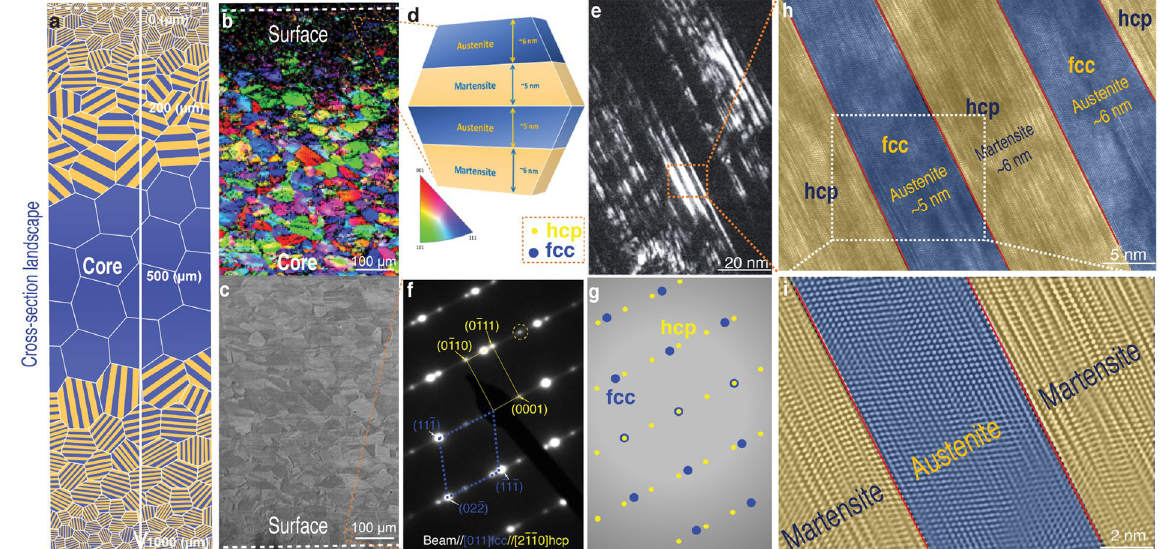
Figure 3. Multi-scale structural characterization of the hierarchical steel. ( a ) Schematic of the gradient in grain size distribution of our hierarchical steel with depth from one topmost surface (outlined by dashed line) to the lower surface of the steel (~1000 µ m in total). ( b ) The EBSD phase map and ( c ) SEM micrograph across the cross-section. ( d ) Nano-sized martensite and austenite phase distribution in one typical grain. Grain sizes are about 15 to 20 nm at the topmost surface, outlined by dashed line in ( b) ,( c ) and ( e ). A typical dark-field TEM image taken at ~100 nm deep underneath the surface of our steel where bright area/bands are ε -hcp martensite. ( f) The SAED patterns corresponding to ( e) clearly show the combination of diffraction spots from both austenite and ε -hcp martensite. ( g ) Schematic illustration of the SAED patterns of ( e) The relatively weak spots (yellow spots) are from the ε -hcp martensite, with the axis of [2110] hcp, and the relatively strong spots (blue spots) are from the austenite, with the axis of [011] fcc. The austenite has the following orientation relationship with the ε -hcp martensite: [011] fcc and [2110] hcp, and (111)fcc//(0002)hcp . ( h) shows a high-resolution image of the dash box selection in ( e) which illustrates the alternative arrangement of the two nano-scale phases: martensite and austenite (both with thicknesses of ~5 to 7 nm). The nano-lamellar martensite produced by strain-induced phase transformation from austenite matrix. ( i ) shows an IFFT image corresponding to the selection in ( h